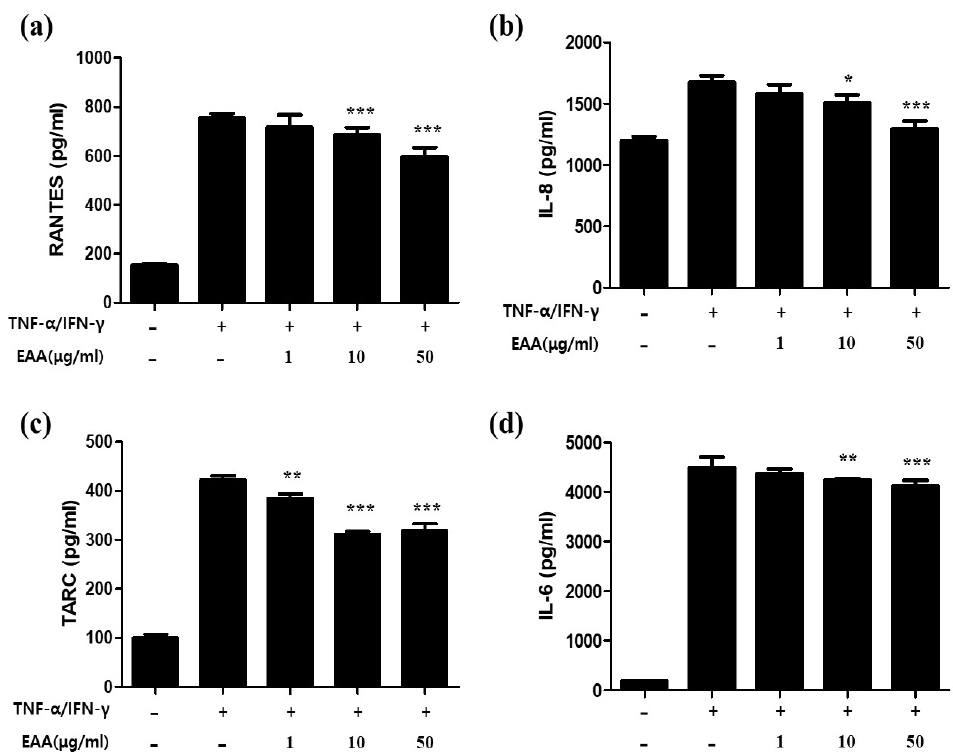
Figure 2. Inhibitory effects of EAA on TNF- α /IFN- γ -induced pro-inflammatory cytokine and chem- okine production in HaCaT cells. Cells were pretreated with the indicated concentrations of EAA (1, 10, and 50 µg/mL) for 1 h and then were stimulated with TNF- α /IFN- γ (10 ng/mL each) for 24 h. Production of ( a ) RANTES, ( b ) TARC, ( c ) IL-6, and ( d ) IL-8 was determined using culture superna- tants of HaCaT cells. Results are expressed as a mean percentage in the treated cells compared to the control (solvent) ± S.E. of three independent experiments performed in triplicates. * p < 0.05, ** p < 0.01, and *** p < 0.001 compared with the TNF- α /IFN- γ -treated control group.